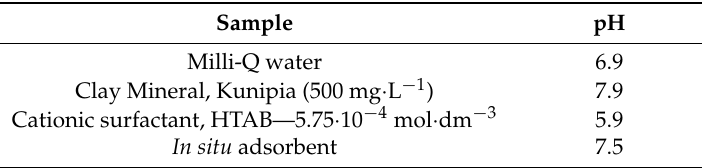
Table 1. pH values measured in the studied samples.